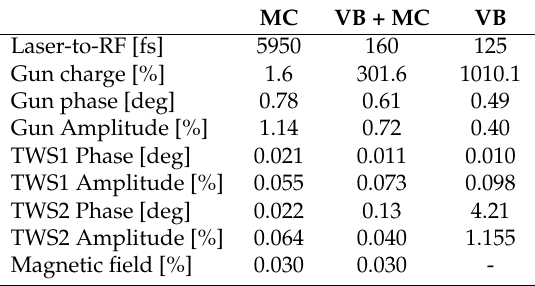
Table 6. Comparison of the jitter tolerances corresponding to three typical working points in which the beam is compressed by velocity bunching (VB), magnetic compression (MC) or their combination (VB+MC). The tolerances have been studied in reference [77] using the code Elegant [79]. The